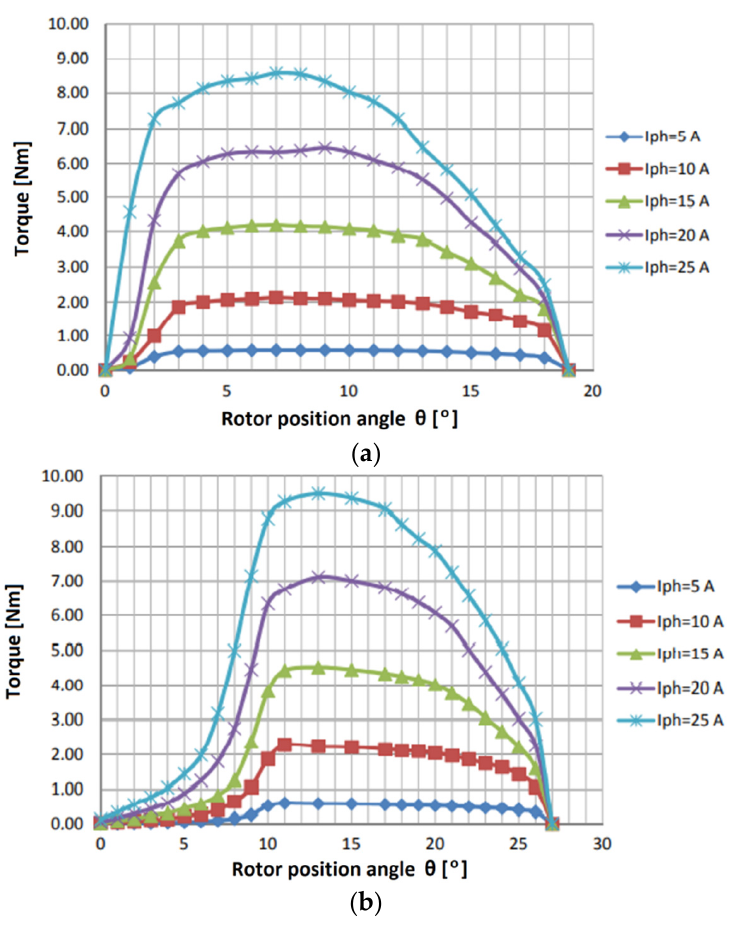
Figure 11. Characteristics of the static torque generated by the tested SRM 8/6 motor with a straight pole rotor as a function of the rotor position angle θ and the value of the phase current I ph : ( a ) sym- metrical; ( b ) asymmetrical.